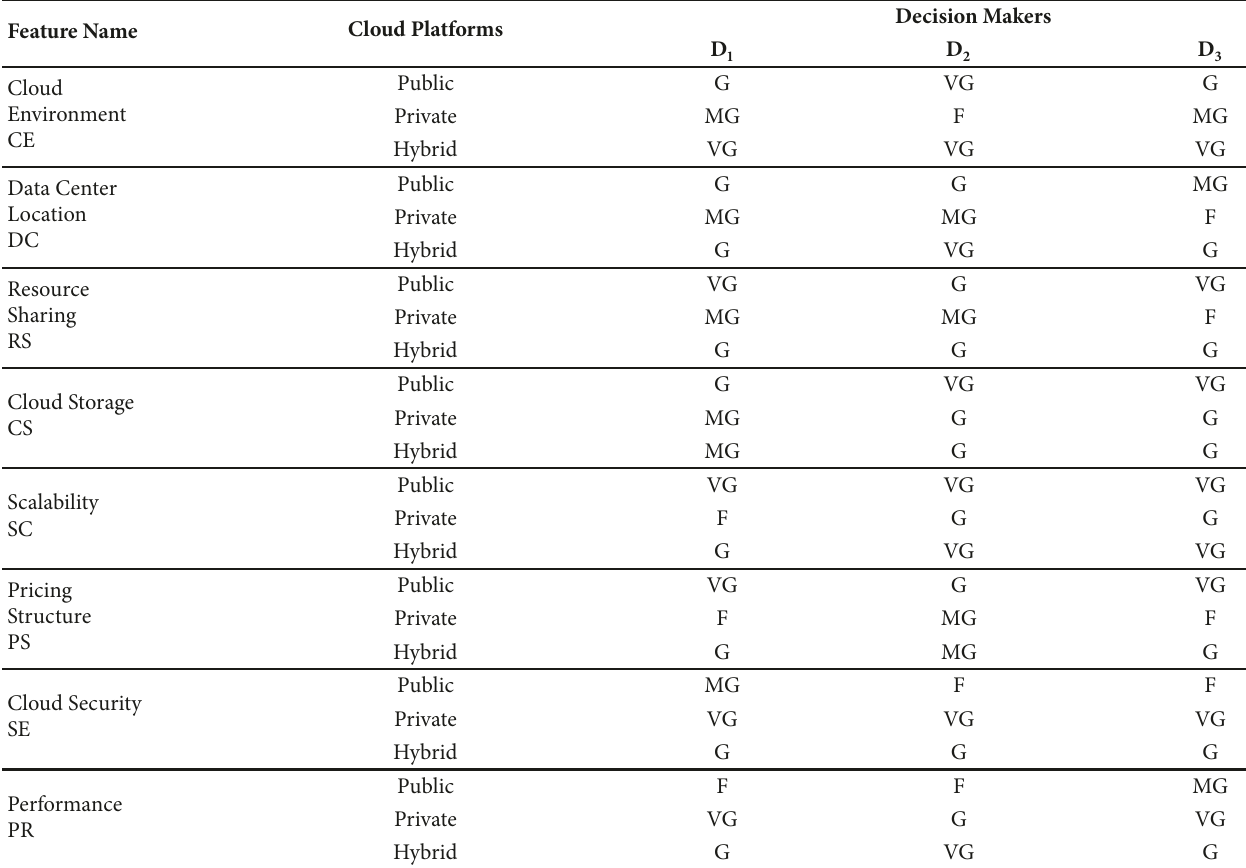
Table 6: Assessment on different platforms by decision makers.